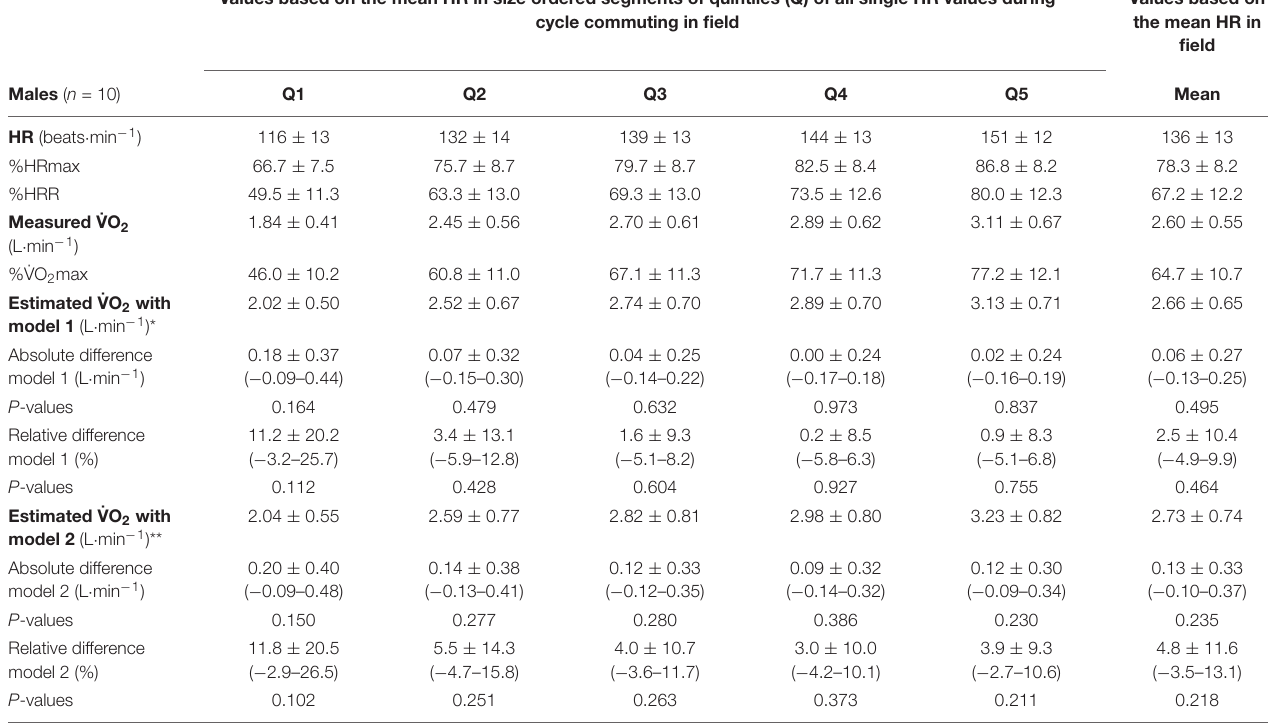
Values are presented as mean ± SD. TABLE 4 | The heart rate (HR) spectrum during cycle commuting in field as well as the measured and estimated oxygen uptake (˙VO 2 ) at these positions for males. Values based on the mean HR in size ordered segments of quintiles (Q) of all single HR values during cycle commuting in field